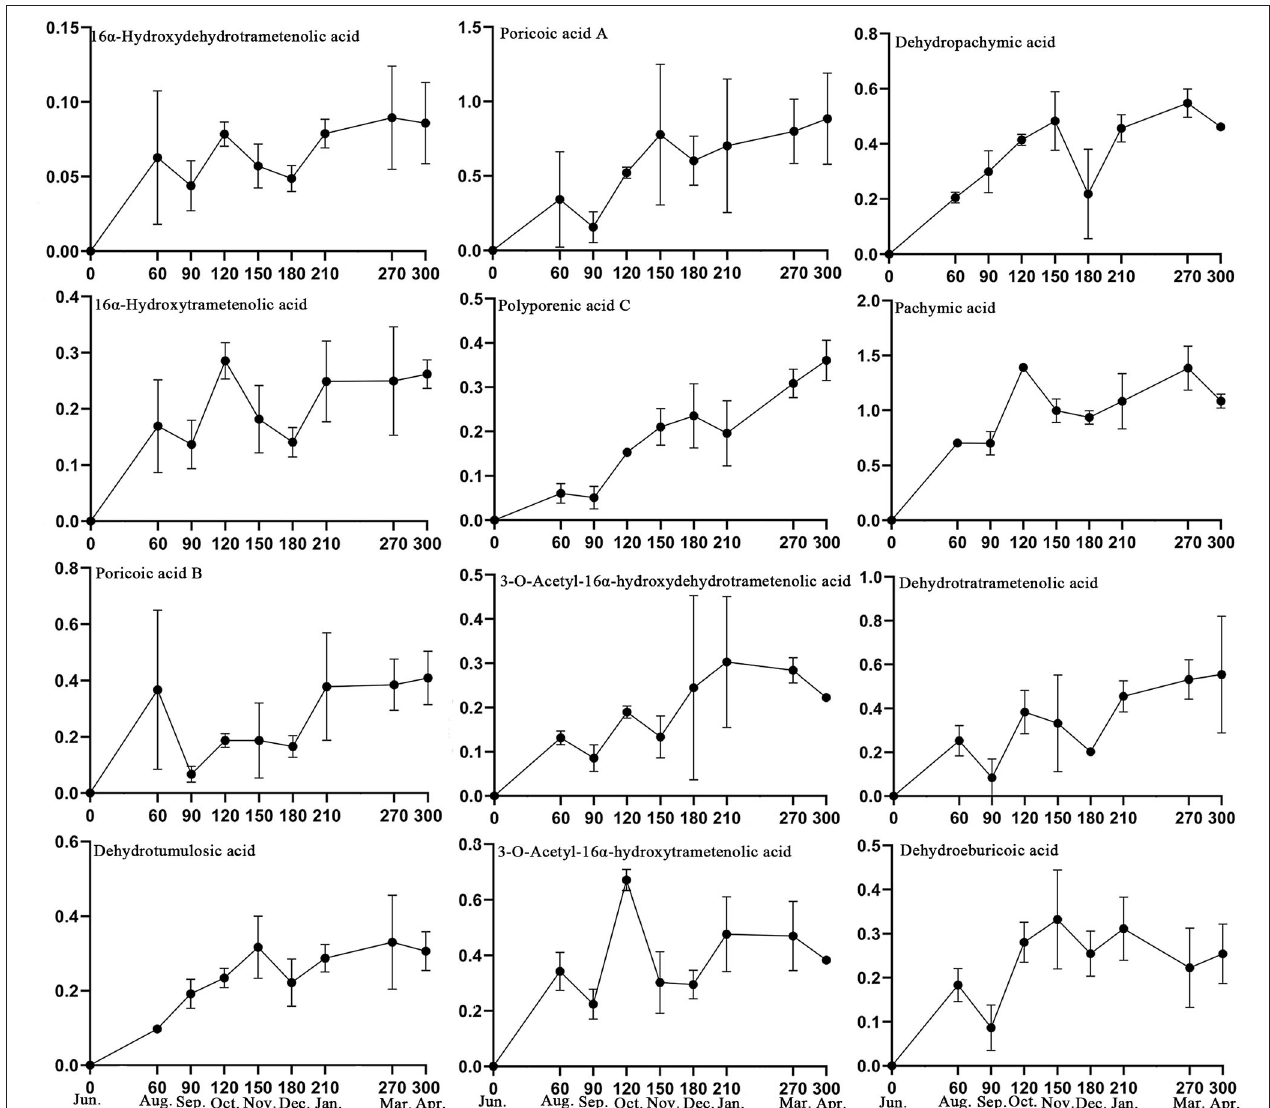
FIGURE 5 | Content levels (mg/g) for the 13 triterpenoid acids in the nine growth periods of